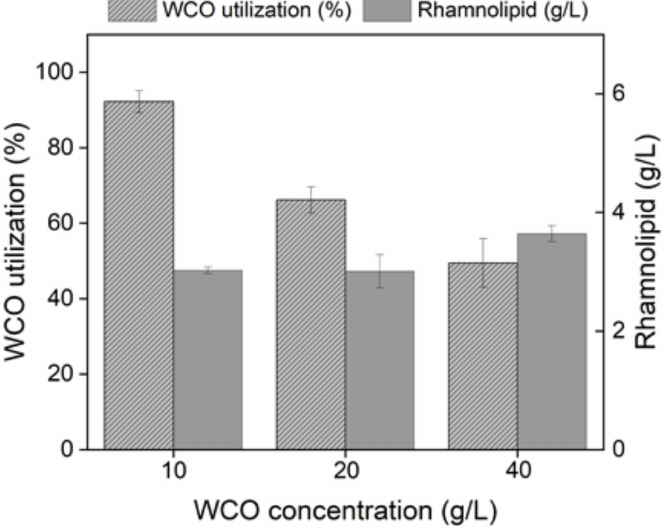
Figure 6. WCO tolerance test of Pseudomonas aeruginosa WO2.